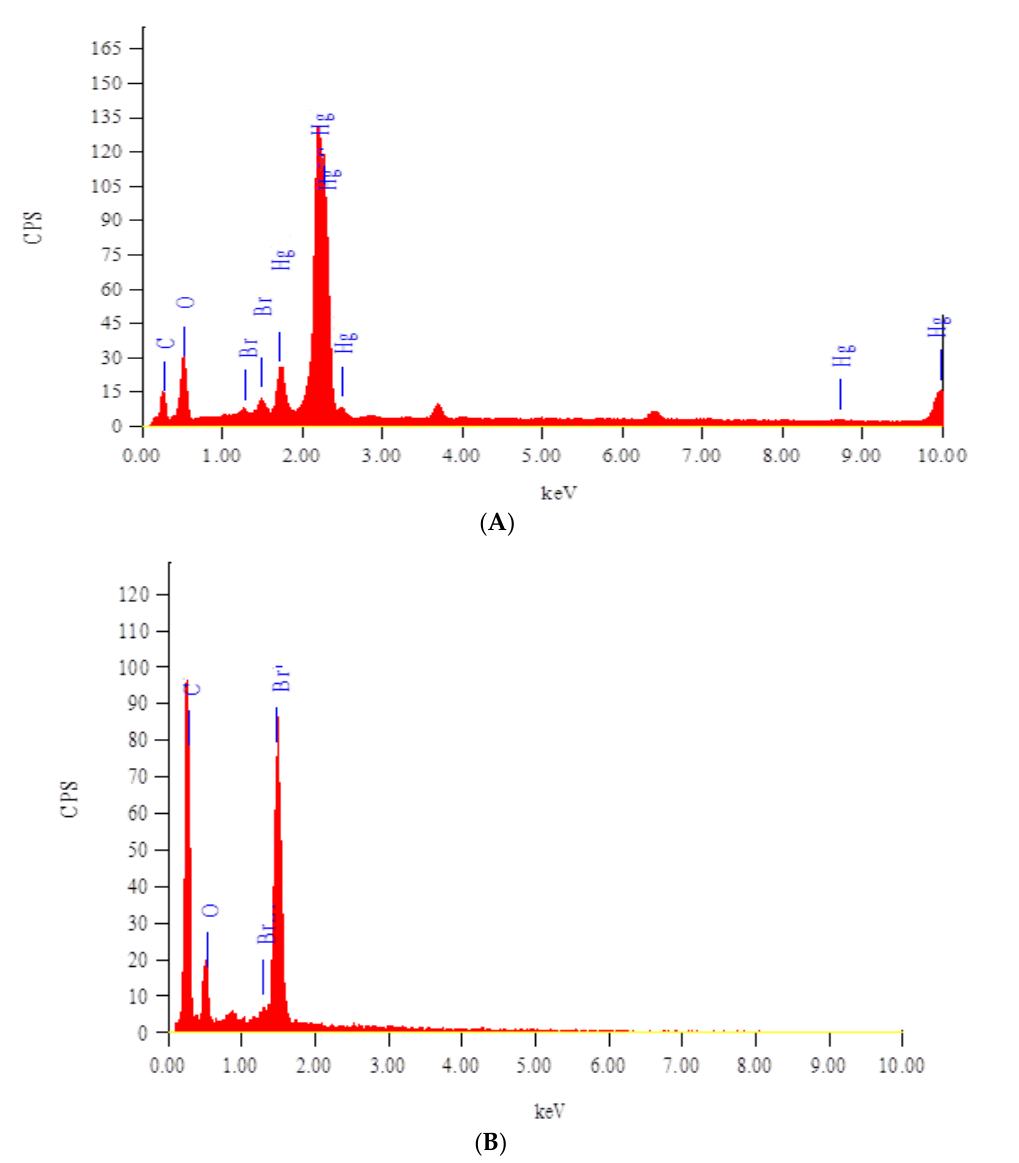
Figure 4. SEM micrographs of ( A ) control membrane and ( B ) optimized membrane used for sens- ing mercury (II).